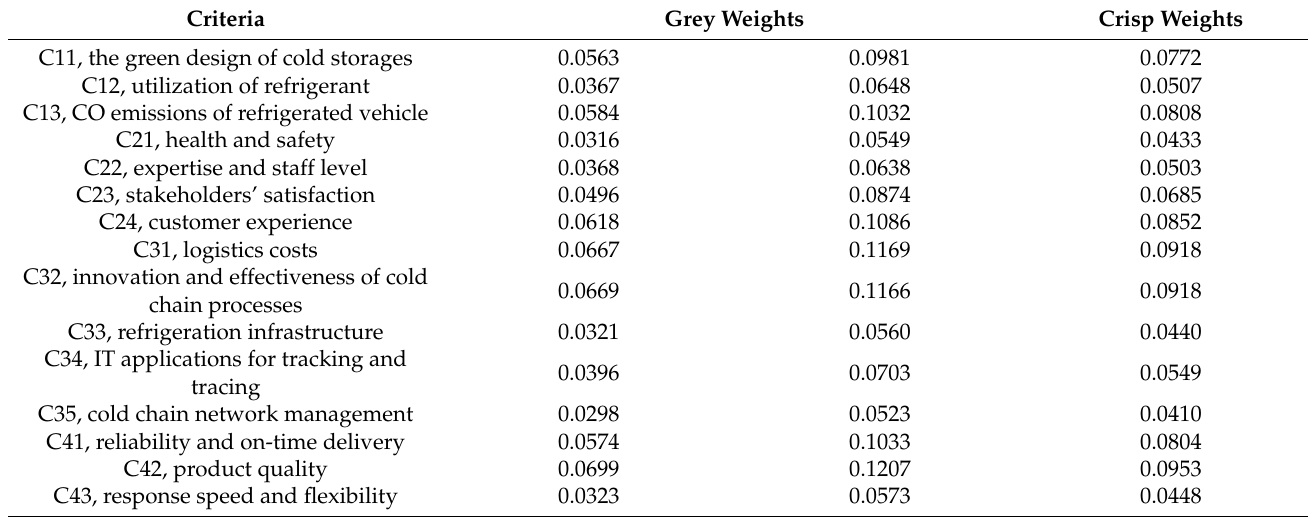
Table 8. The grey weights from the